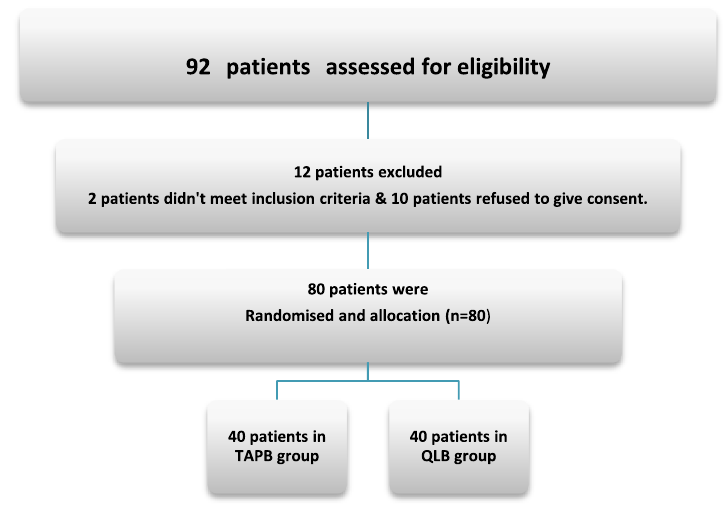
Fig. 1 Exclusion